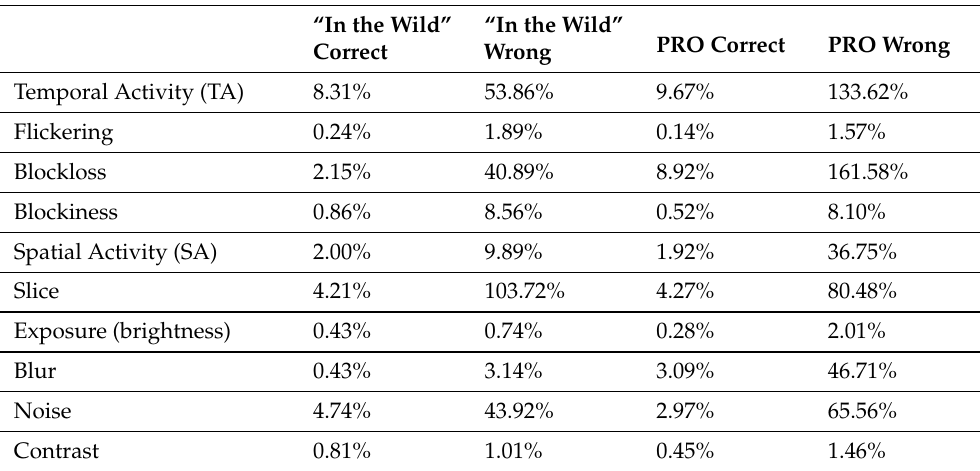
Table 5. Percentage deviation of